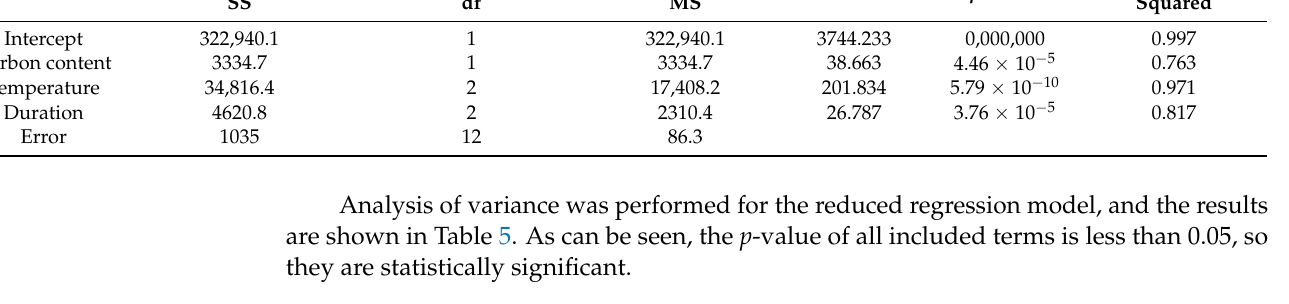
Table 5. Analysis of variance for the reduced regression